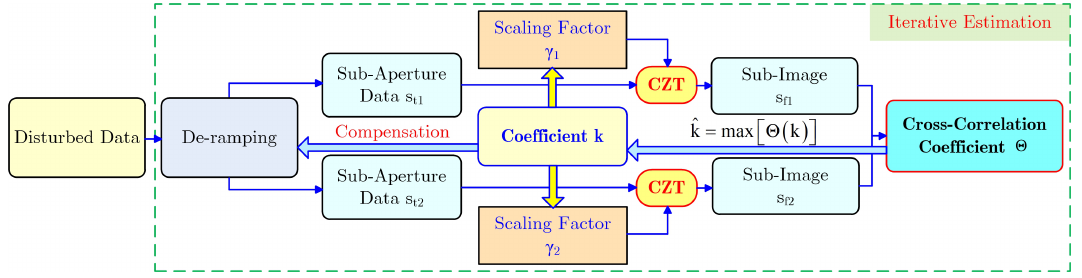
Figure 3. Basic principle illustration of Azimuth-Variant Map-Drift Algorithm (AVMDA). CZT = Chirp-Z